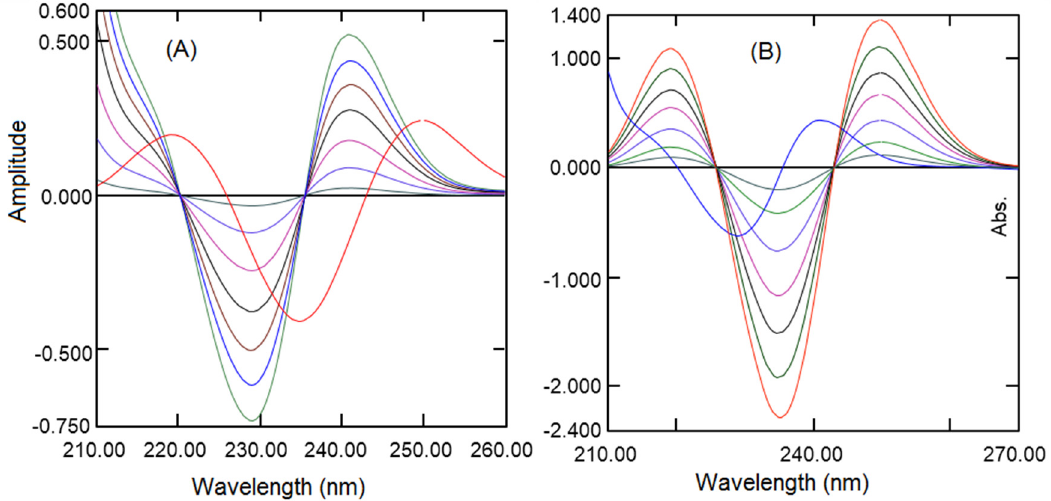
Figure 9. Second-derivative spectra of metformin (2.0, 5, 10, 15, 20, 25, and 30 µg/mL) with RGE (red) ( A ) and second derivative spectra of RGE (1, 2, 4, 8, 12, 16 20 and 24 µg/mL) with MFH (blue) ( B ). Table 3. Calibration parameters results for both the proposed